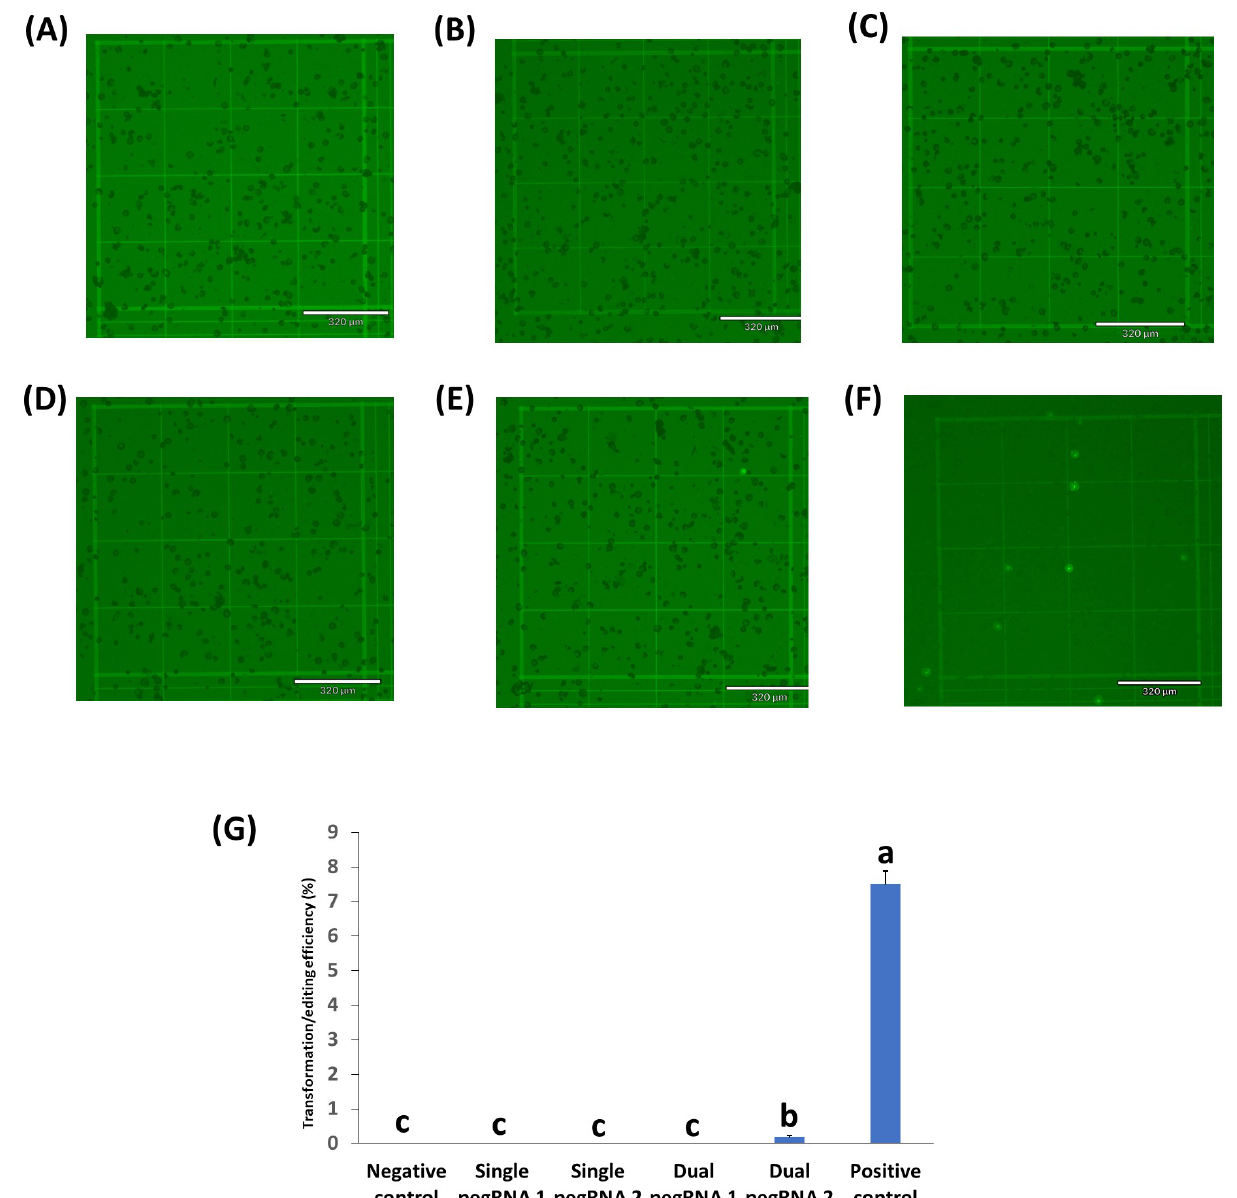
Figure 6. Prime editing in cowpea protoplasts transformed using single or dual pegRNAs containing vectors. ( A ) negative control (no GFP plasmid/prime editing vectors); ( B ) protoplasts with single pegRNA1 containing vector; ( C ) protoplasts with single pegRNA2 containing vector. ( D ) protoplasts with dual pegRNA1 containing vector; ( E ) protoplasts with dual pegRNA2 containing vector; ( F ) positive control (protoplasts with CmYLCV_GFP vector); ( G ) transformation efficiency (TE) of protoplasts transformed with different prime editing vectors. TE was calculated after 24 h and incubation in 50% PEG solution for 10 min with 100 µg plasmid DNA of each prime editing vector. Values represent means ± SE (n = 6). The different letters indicate significant differences at p < 0.05. Scale bar length for all pictures was 320 µm. Micrographs under the bright field are shown in Supplementary Figure S6.